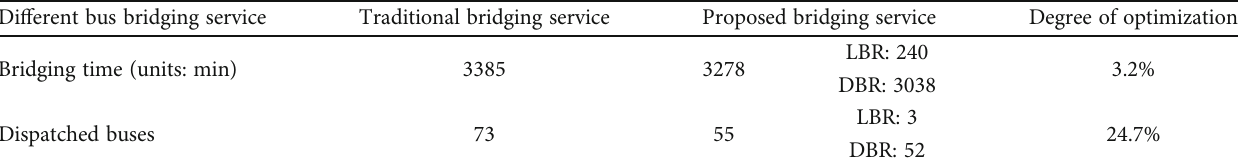
Table 7: Comparative analysis of the optimized bridging service and traditional bridging service. Di ff erent bus bridging service